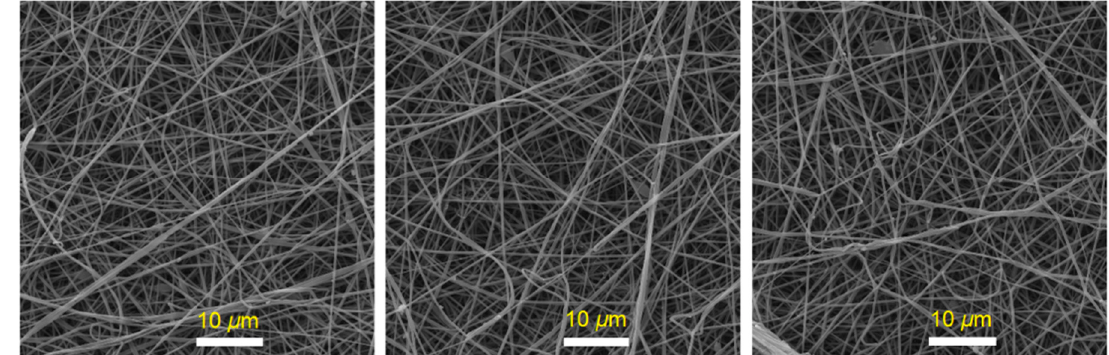
Figure 2. SEM images of electrospun glass nanofibers.